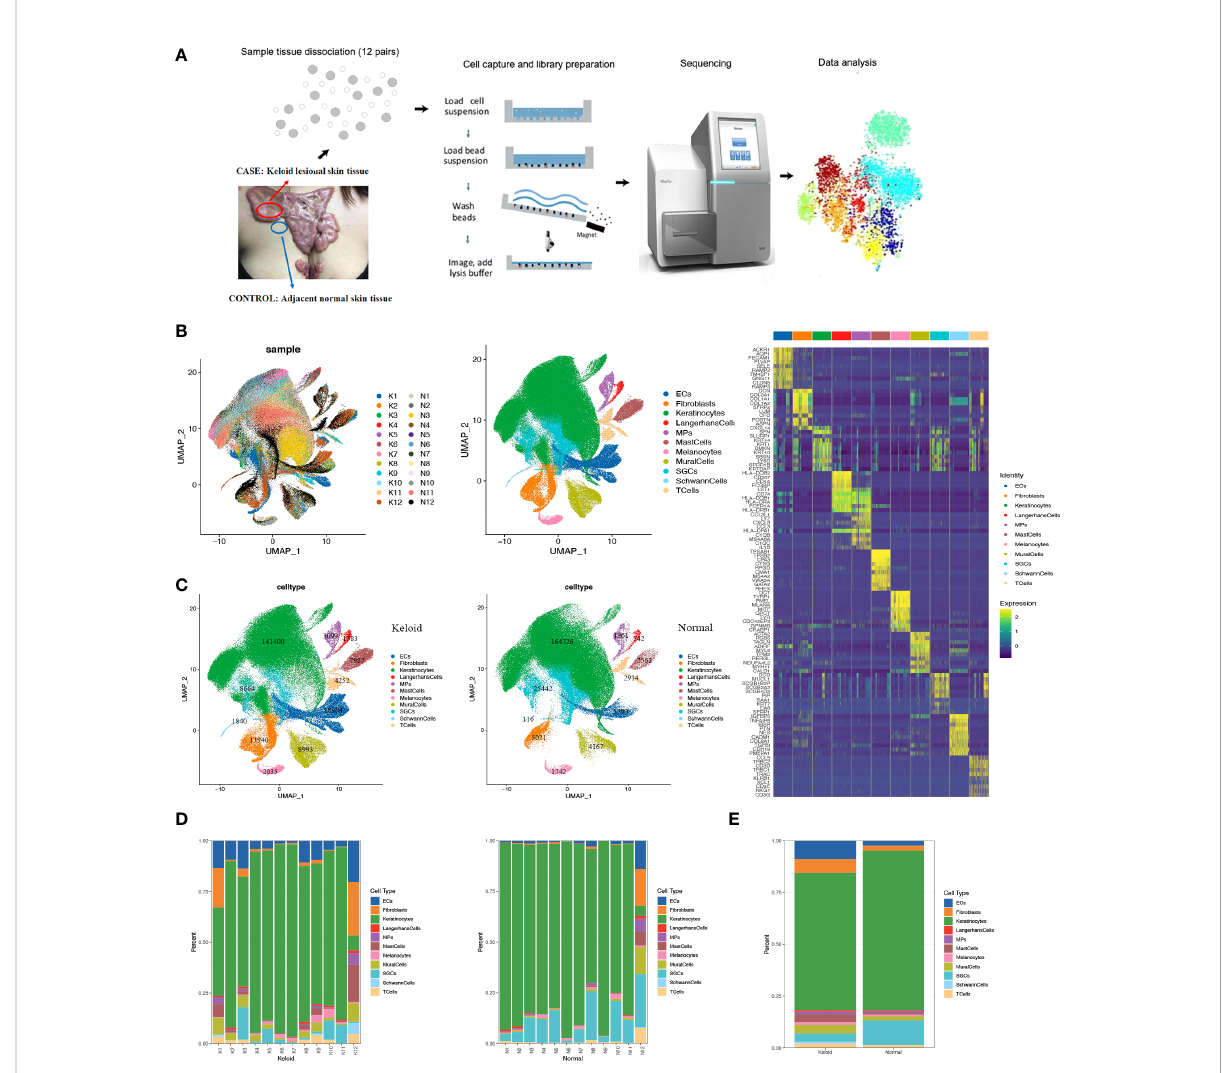
FIGURE 1 Single-cell RNA-seq (scRNA-seq) reveals the cellular diversity and heterogeneity of keloid skin tissue. (A) Schematic representation of the experimental procedure. Keloids and adjacent normal skin tissues were harvested separately at the time of surgery (n=24). (B) Uniform Manifold Approximation and Projection (UMAP) of unbiased clustering of 427,171 cells reveals 11 cellular clusters. Clusters are distinguished by different colors. The number in the parenthesis indicates the cell count. (C) Hierarchical clustering of the clusters based on the average expression of the 2,000 most variable genes. (D) Comparison of the ratio of cells in keloids and adjacent normal skin tissues. (E) Representative molecular signatures for each cell cluster. SGCs, sweat gland cells; ECs, vascular endothelial cells; MPs, mononuclear